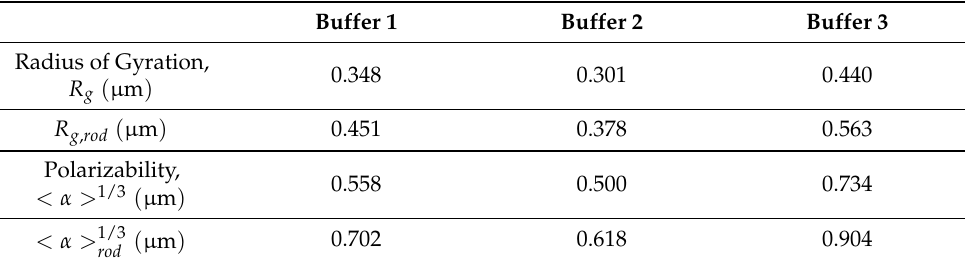
Table 9. Other structural and electrical properties of single actin filaments predicted with an accuracy of three digits of